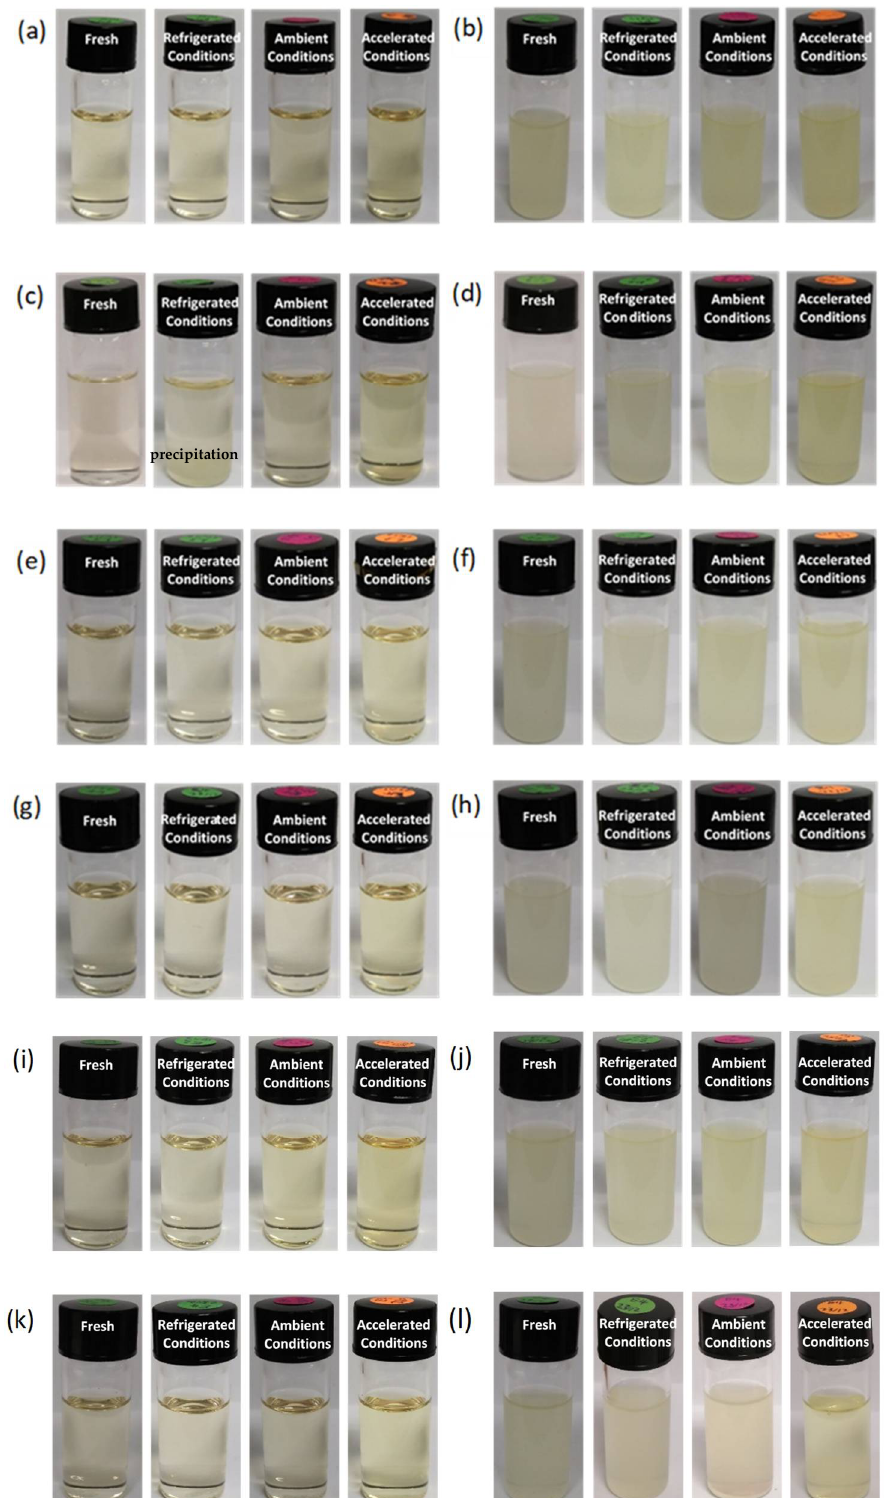
Figure 6. Physical appearance of ( a ) NME-1; ( b ) NMEG-1; ( c ) NME-2; ( d ) NMEG-2; ( e ) NME-3; ( f ) NMEG-3; ( g ) NME-4; ( h ) NMEG-4; ( i ) NME-5; ( j ) NMEG-5; ( k ) NME-6 and ( l ) NMEG-6; (Left to Right) Fresh, refrigerated conditions (4 °C/65% RH), ambient conditions (25 °C/60% RH) and accelerated conditions (40 °C/75%).